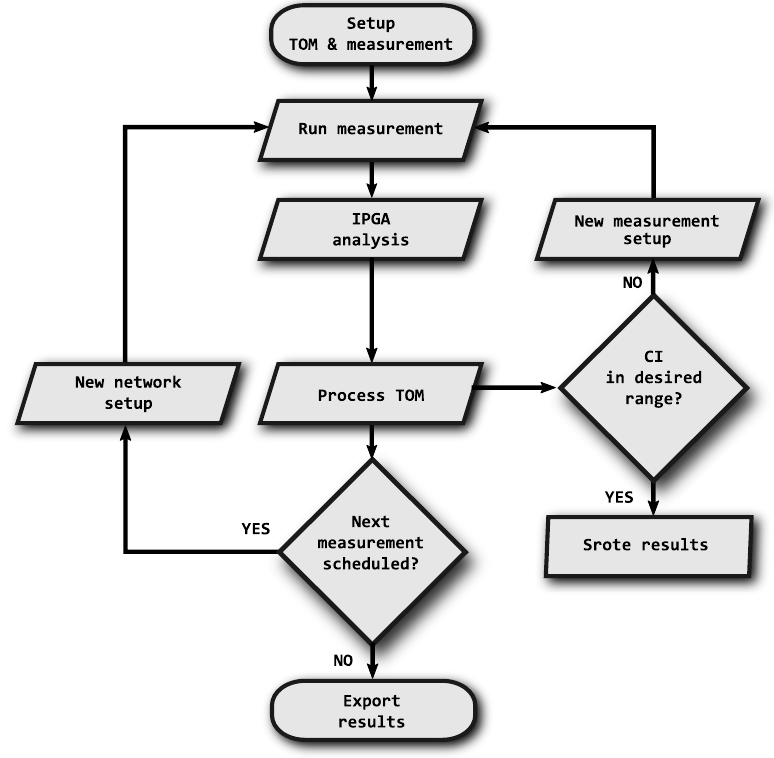
Figure 3. Flowchart of the analysis and evaluation process according to IPGA and